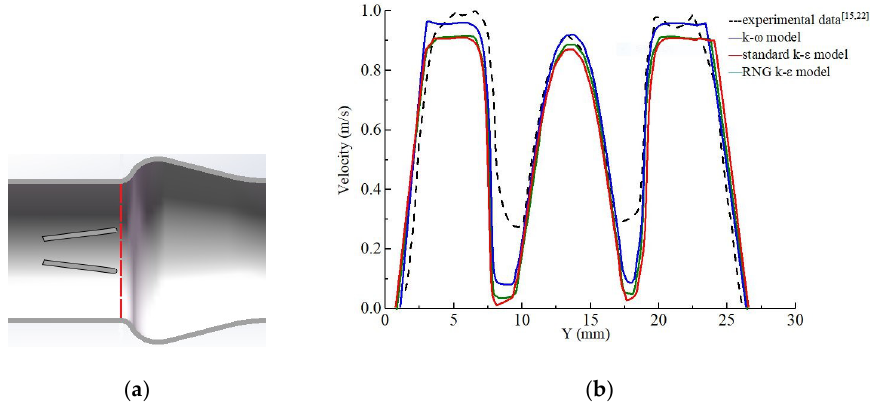
Figure 3. Comparisons of the velocity profiles between the simulation results by di ff erent turbulent models and the experiment results [15,22]. ( a ) Monitoring line at 2.54 mm cross-section after the leaflets. ( b ) Current simulation results and previous experimental data for velocity